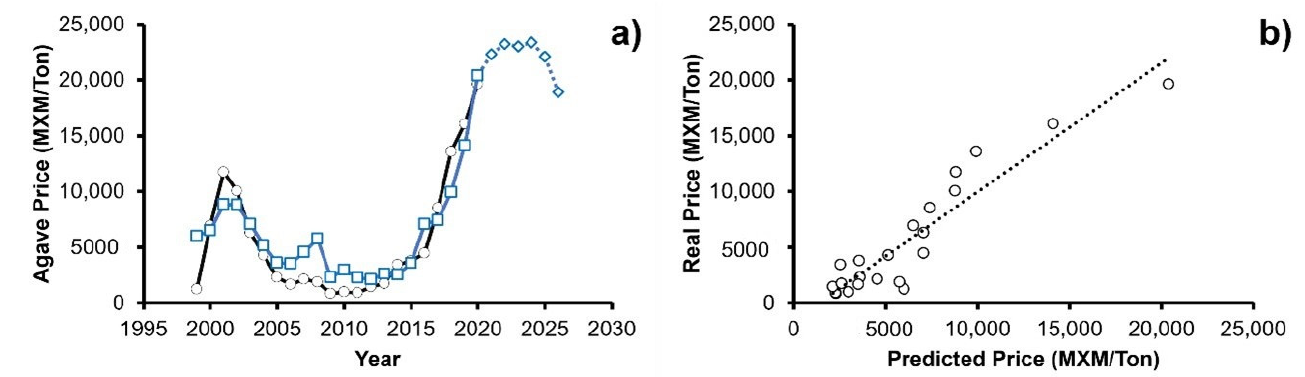
Figure 4. ( a ) ○ Historical data of the price of agave, □ predicted data of the predictive mathematical model for agave price, ◊ estimated projection for the next 6 years using the predictive mathematical model; ( b ) Comparison between the historical data vs. predicted data from the predictive mathematical model proposed.